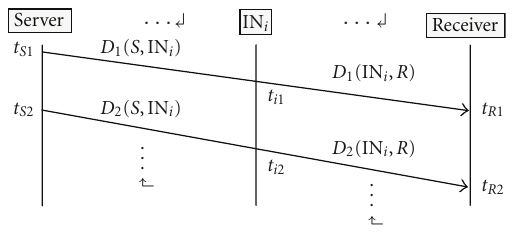
Figure 2: Delay versus jitter in video frame